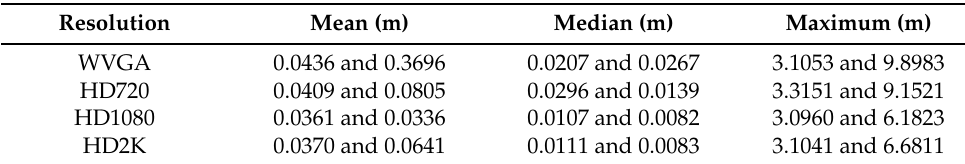
Table 1. Standard deviations of every pixel in the scene for the 100 consecutive depth maps in all four resolutions for the indoor and outdoor scene.